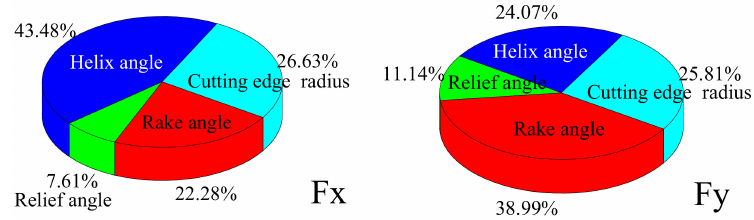
Figure 13. Relative sensitivity of tool geometry parameters to cutting force.